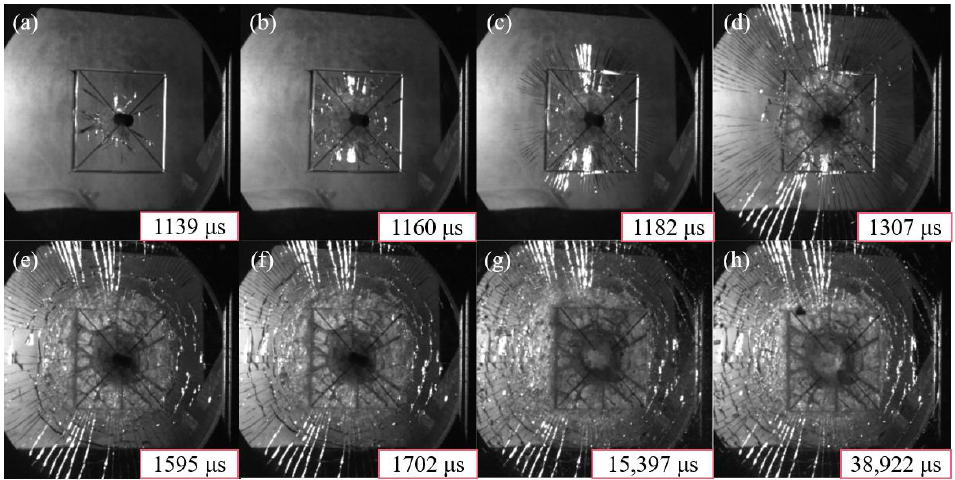
Figure 4. The time evolution of the damage map for the strike face. From ( a – h ): snapshots taken at 1139, 1160, 1182, 1307, 1595, 1702, 15,397, and 38,922 µ s, starting from the triggering of the high-speed camera.